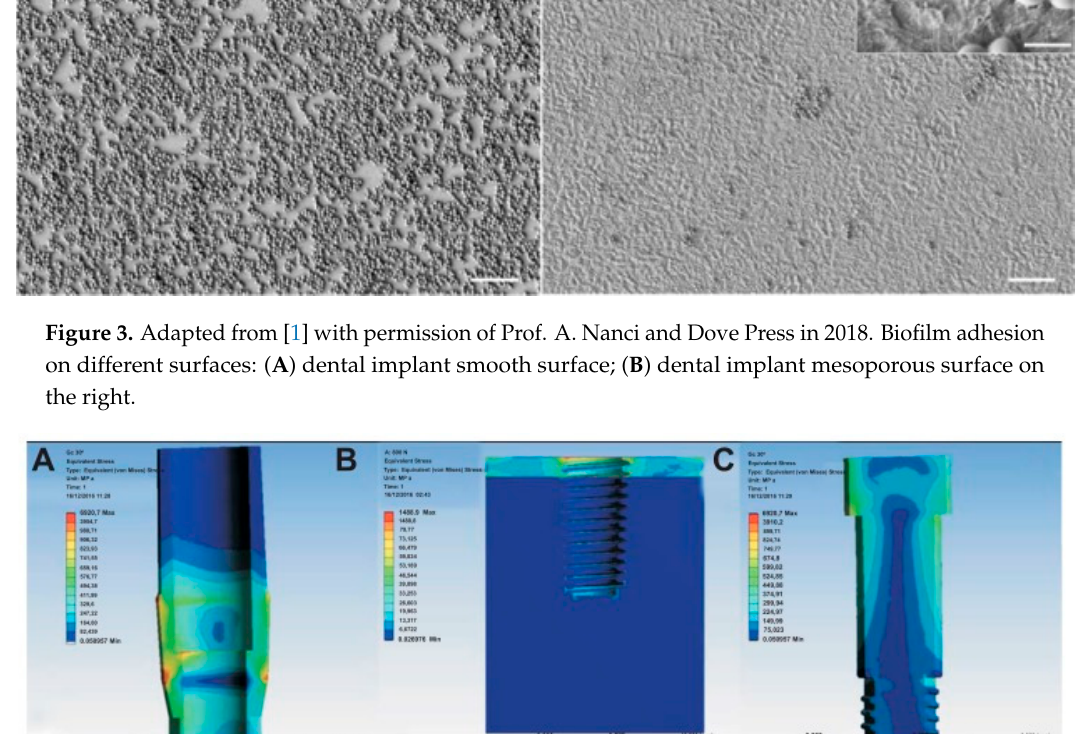
Figure 4. Adapted from [24] with permission of M. Cicciù in 2018. Von Mises and Stress distribution on three different prosthodontics sections; ( A ) located in the abutment section; ( B ) stress located at the bone tissue; ( C ) stress distribution at the passant screw.